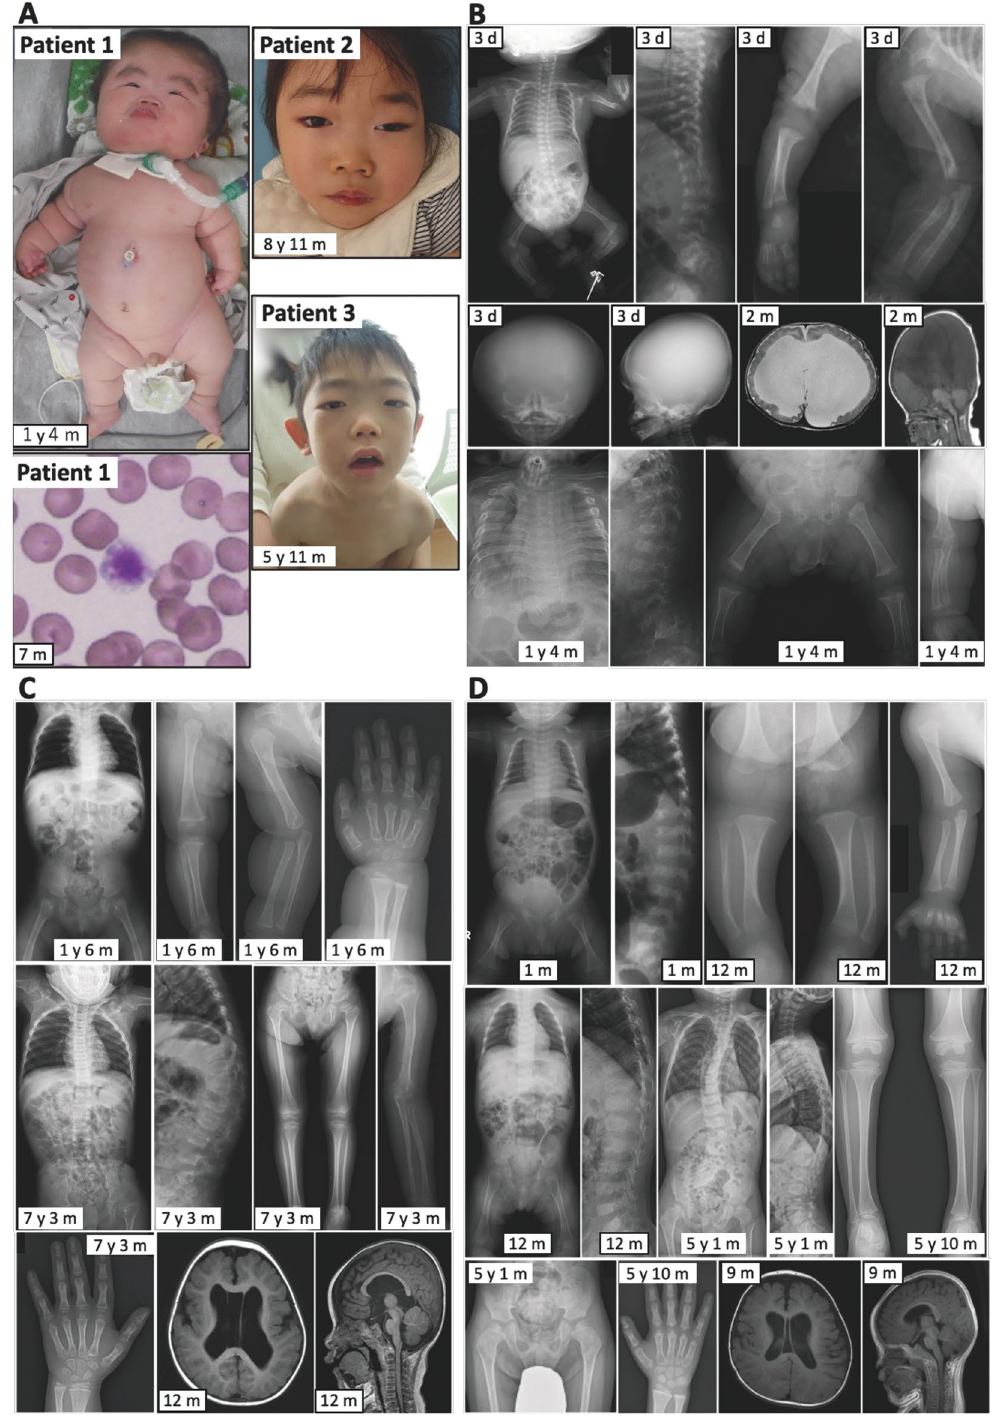
Figure 1. Clinical findings in patients 1–3. y, year; m, month; and d, day. ( A ) Photographs of patients 1–3 and blood smear of patient 1 showing a megathrombocyte. ( B–D ) Radiological findings in patients 1–3,